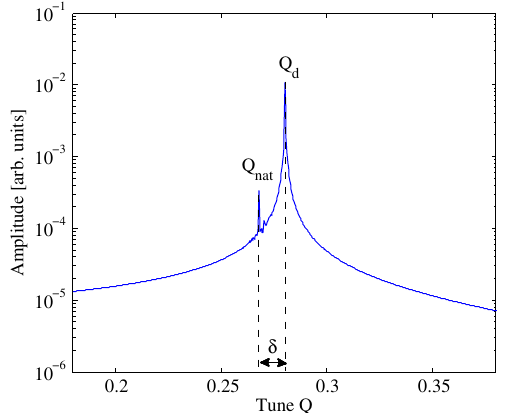
FIG. 2. Simulated spectrum of the transverse beam signal on the ac dipole plateau showing driven Q d and natural Q